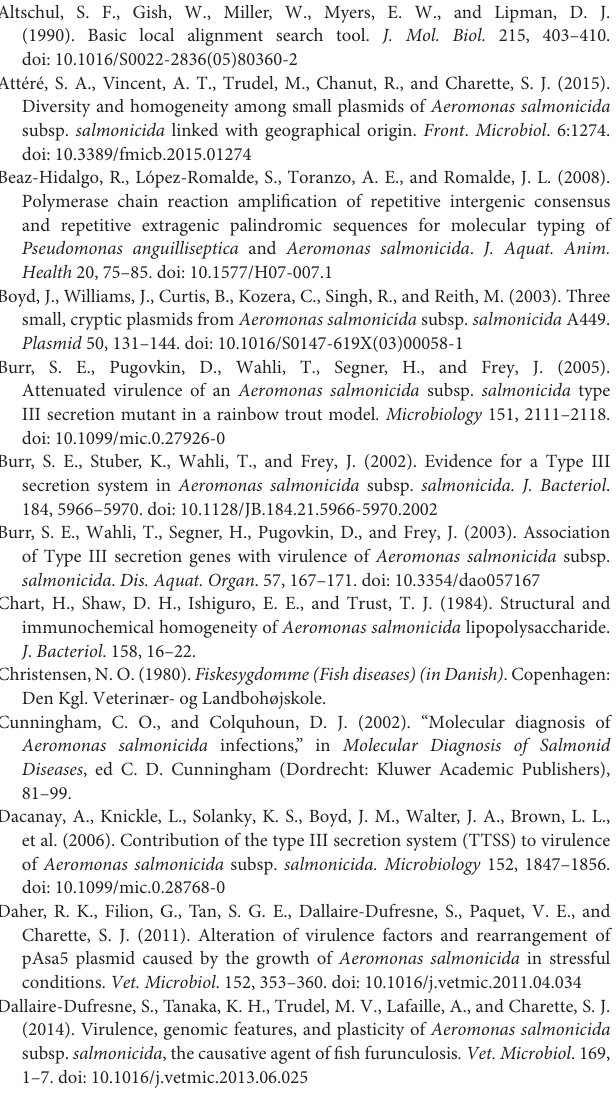
was set to 75% similarity expressed as percent sequence identity (ID) and 60% of alignment length (coverage) of the plasmid, except for plasmid pAsa6 and pAsa7 due to the high level of identity shared between pAsa5 and pAsa6 and between pAsa2 and pAsa7 respectively. Coverage was set to 100% for plasmids pAsa6 and pAsa7 in order for these plasmids being considered as present in an isolate. Following abbreviations are used for percent coverage: Table S6 | Genomic island (GEI) content of the 101 A. salmonicida subsp. salmonicida sequenced isolates and the reference A449. The GEI content is represented as stated in Table S5 for plasmids pAsa6 and pAsa7. Isolates are labeled as stated in Figure 1